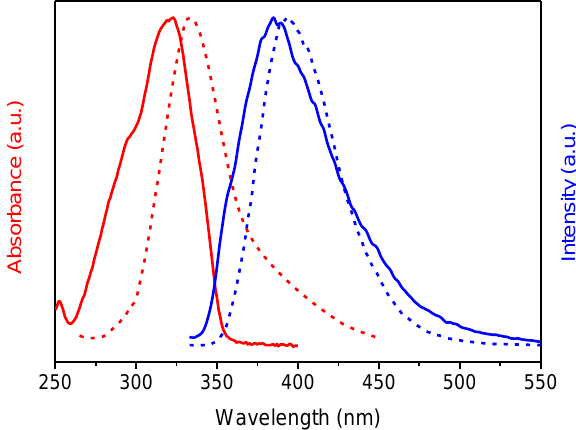
Figure 5. UV-Vis absorption (red) and emission (blue) spectra of PAMAM64– cov –ChCou self-assemblies in water (dashed lines) and in THF solution (solid lines).